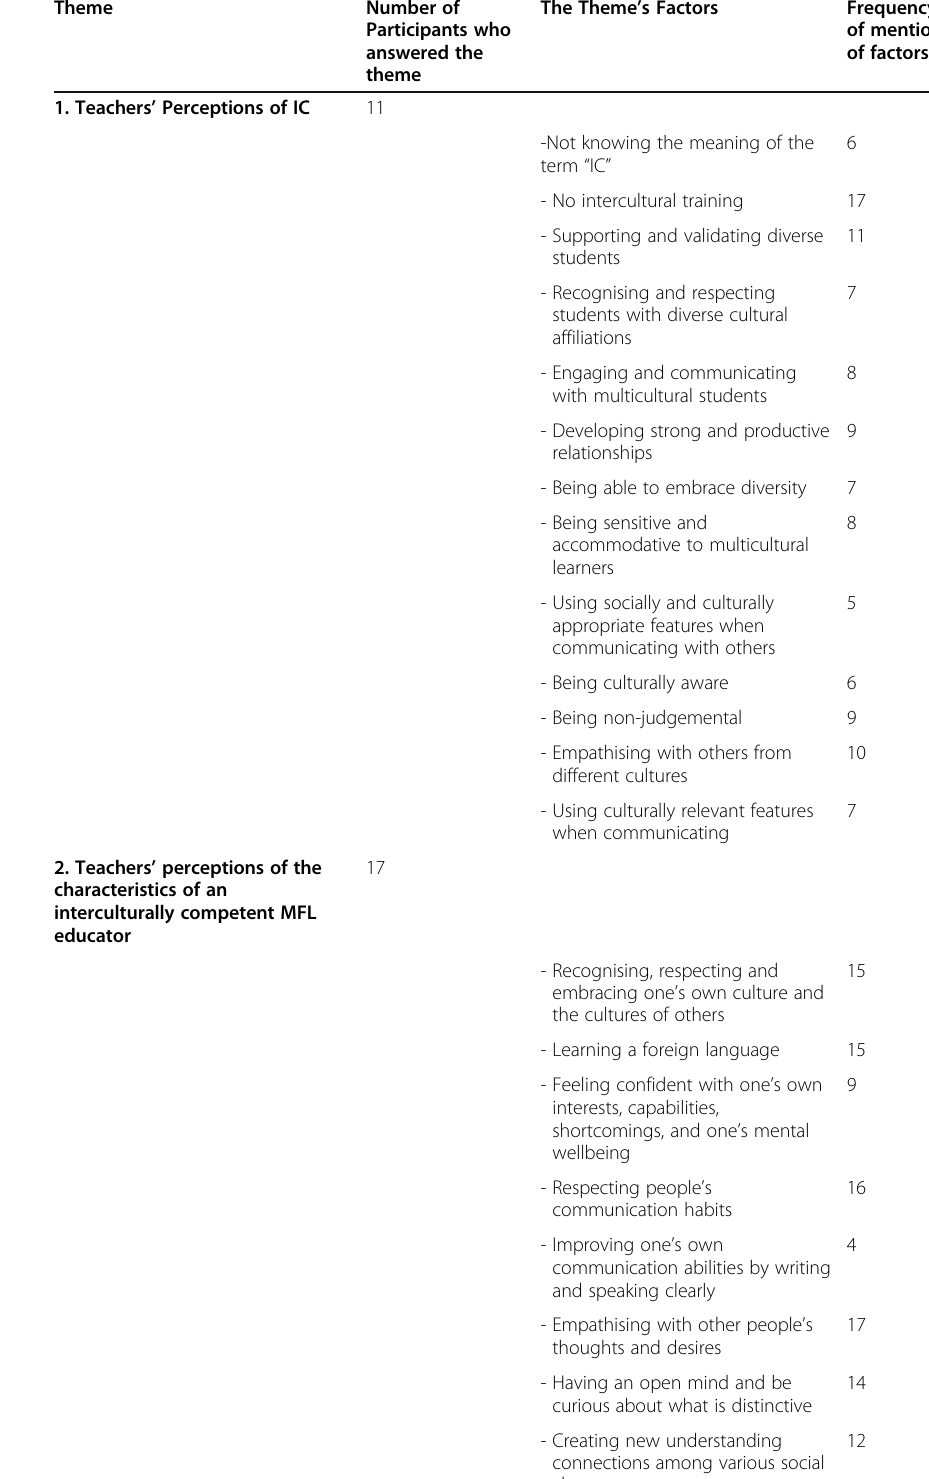
Table 1 The Study Main Themes